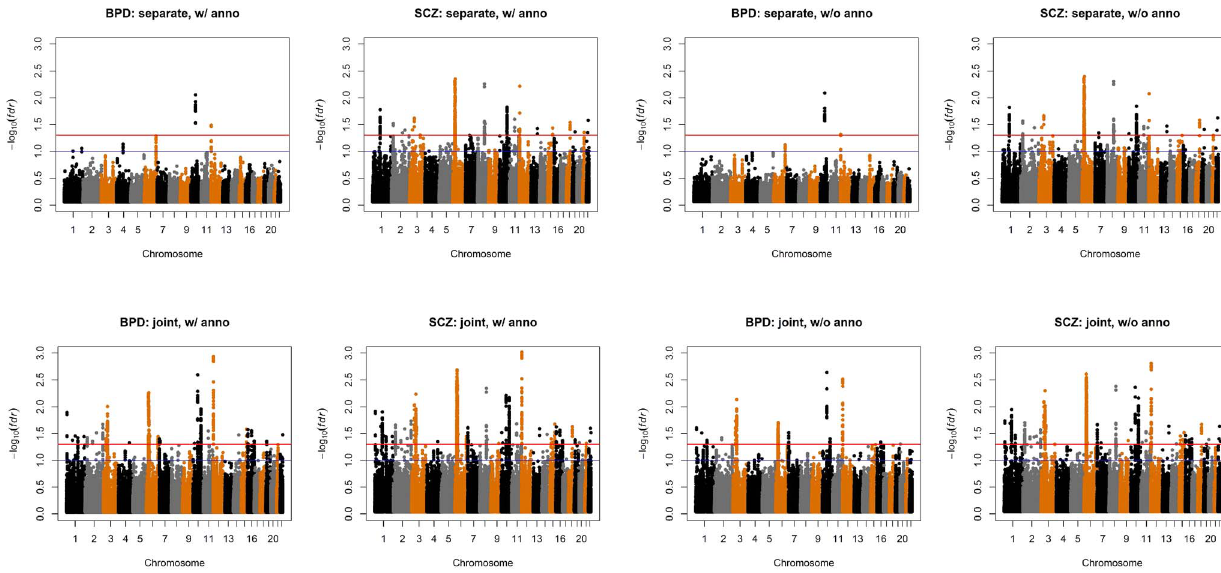
Figure 6. Manhattan plots of BPD and SCZ. Top left panel: separate analysis without annotation. Top right panel: separate analysis with CNS annotation. Bottom left panel: joint analysis without annotation. Bottom right panel: joint analysis with CNS annotation. The red and blue lines indicate local fdr =0.05 and 0.1, respectively.